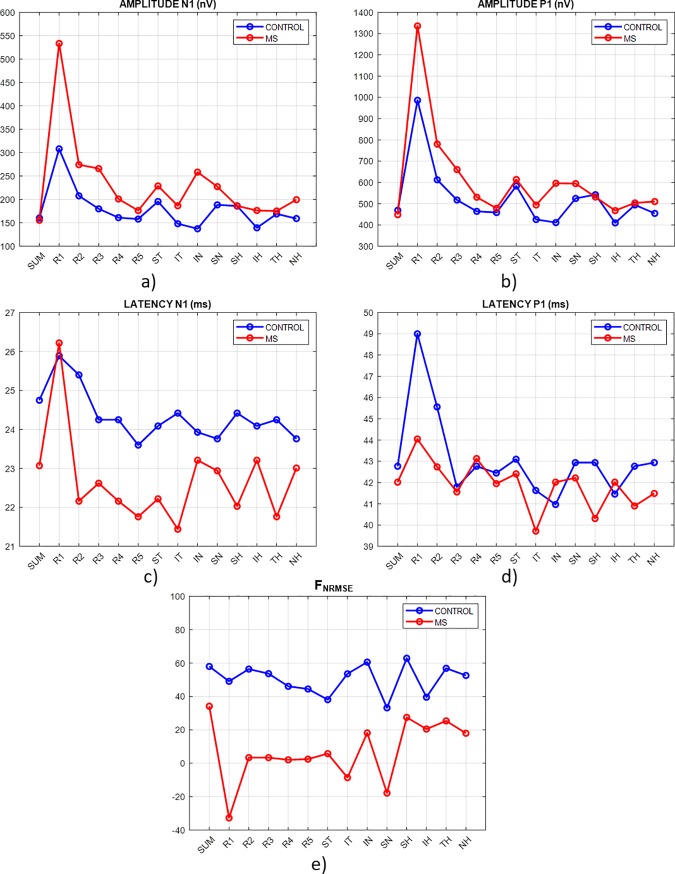
Principal results of the multifocal electroretinogram (mfERG) analysis.